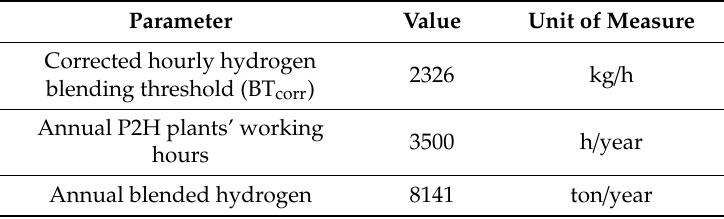
Table 8. Results of the preliminary assessment about hydrogen blending threshold.